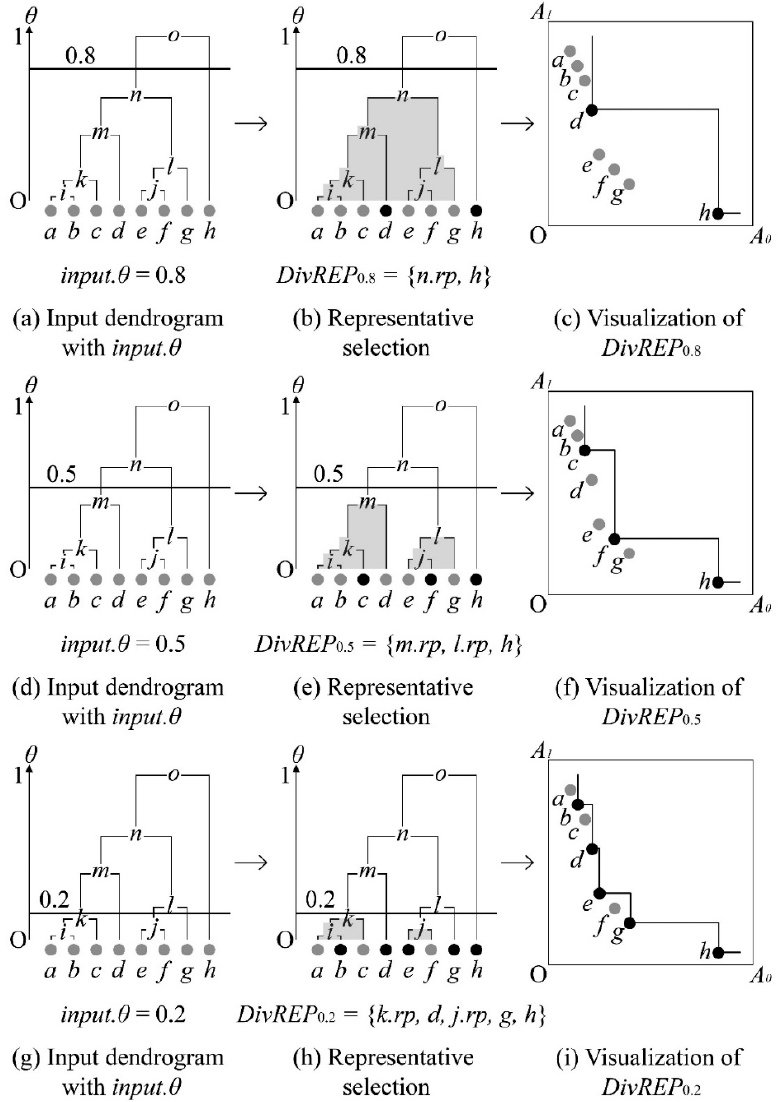
Figure 5. An example of diverse representative skyline points selection.